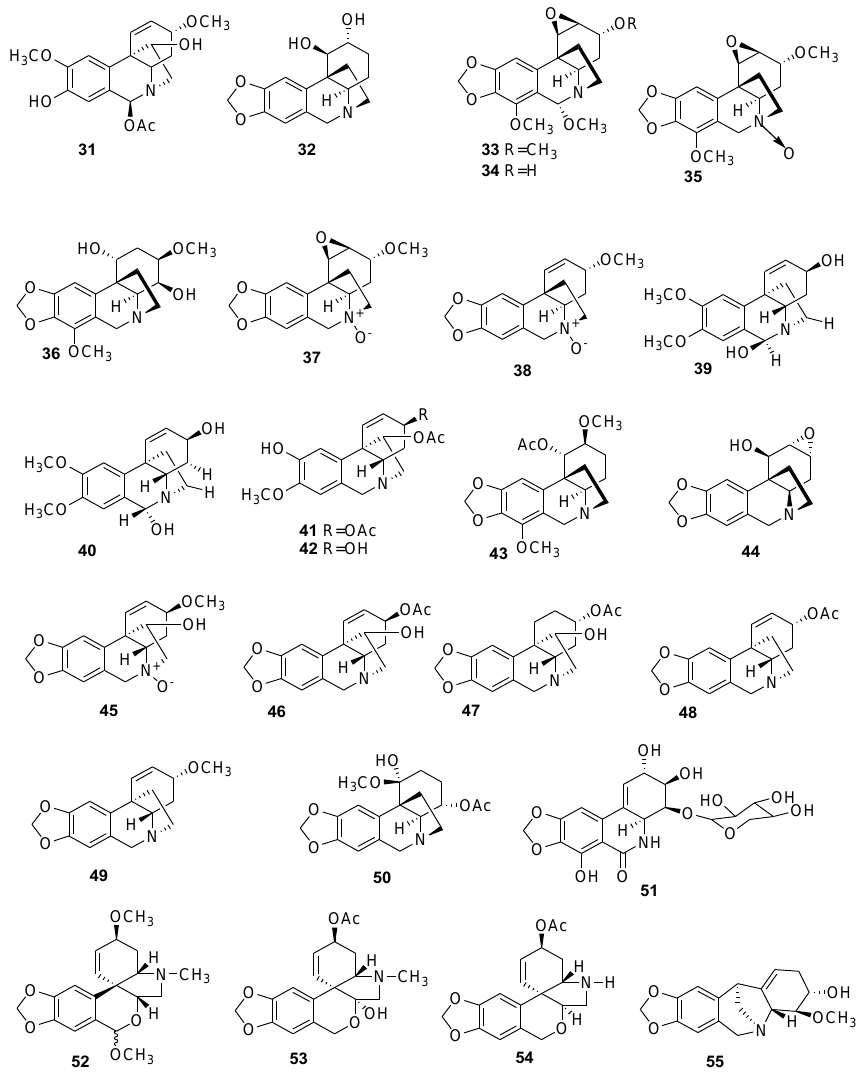
Figure 5. Chemical structure of new alkaloids crinine-, narciclasine-, tazettine-, and montanine-type ( 31 – 55 ). Numbers in bold refer to the compounds depicted in Table 2.